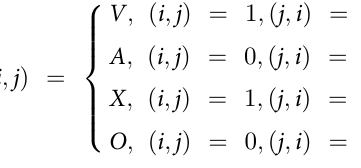
• Final Reachability Matrix Formation The final reachability matrix (FRM) was developed by incorporating the transitivity repre- sented by 1 � . An elementary assumption of ISM is that if element X is related to Y and ele- ment Y is connected with Z, it means X is necessarily related to Z. FRM was computed according to the Boolean rules below given.